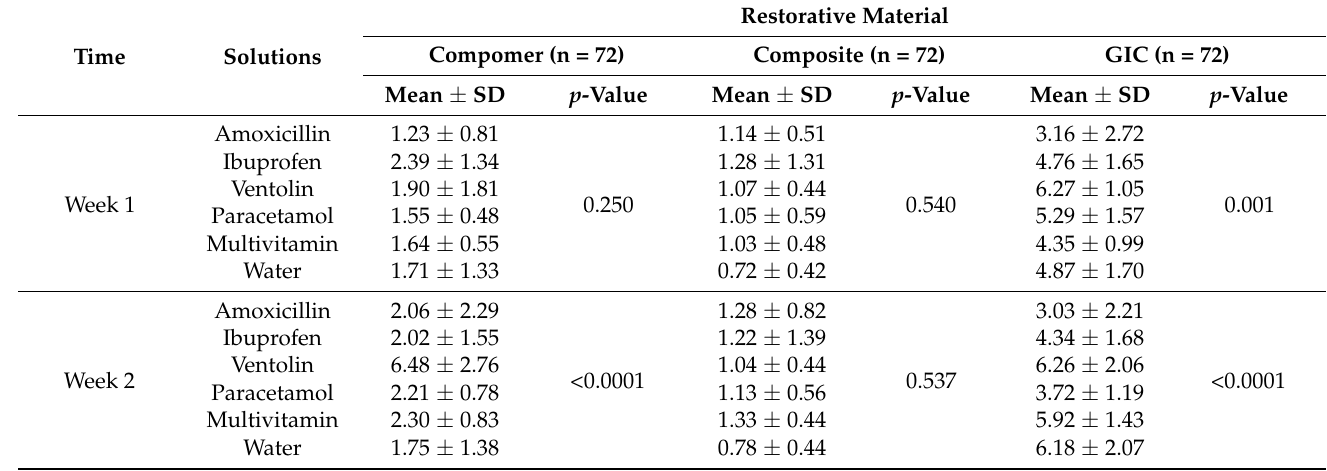
Table 3. Mean and standard deviation of ∆ E values of the restorative materials tested with pedi- atric